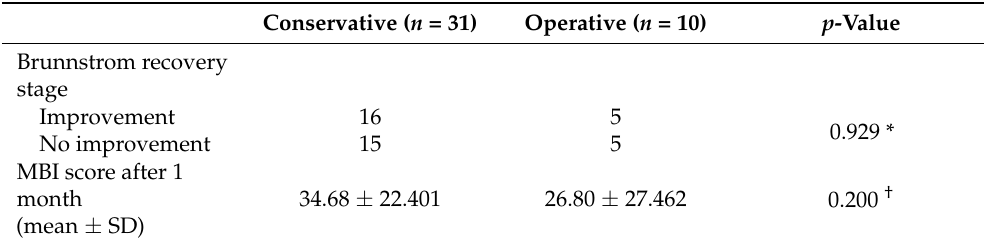
Table 3. Distribution according to whether there was improvement between the operated and conservatively treated